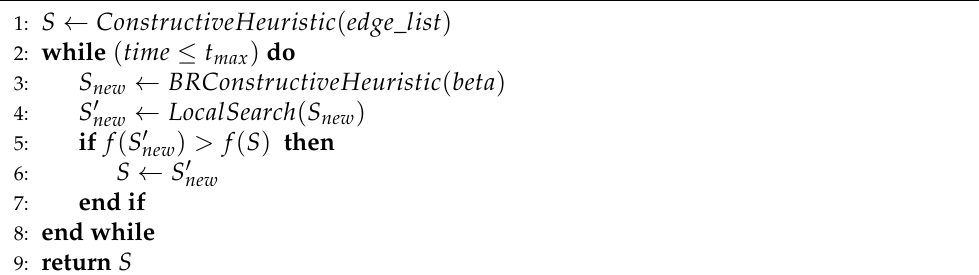
Algorithm 2 Multi-start biased-randomized constructive heuristic ( t max , beta , edge _ list